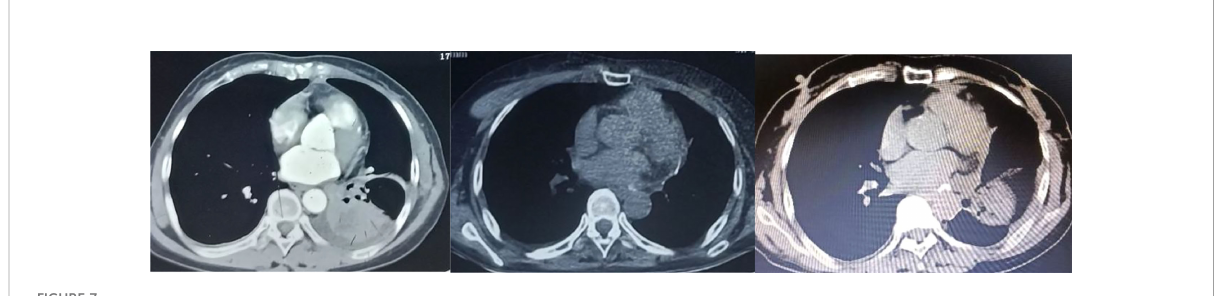
FIGURE 7 Chest CT contrast (From left to